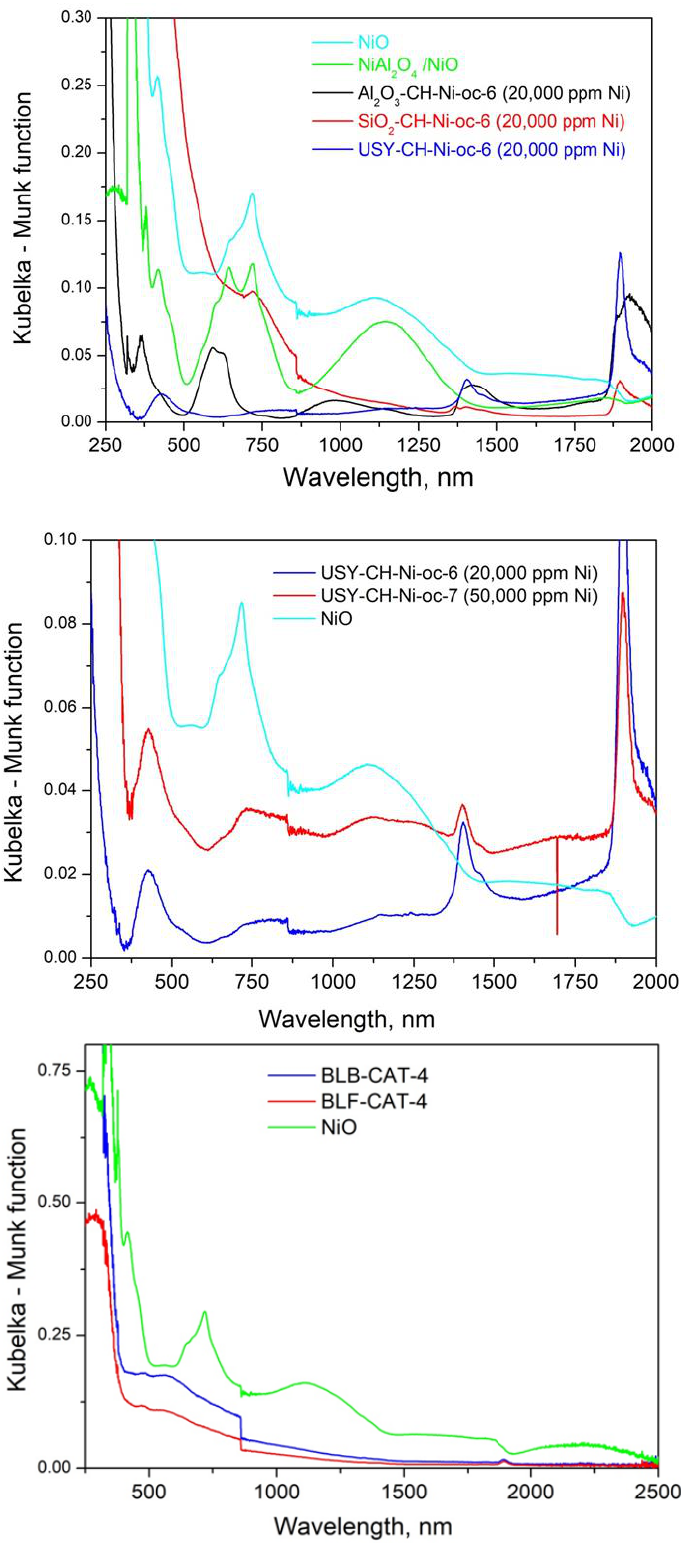
Figure 11. UV-Vis near IR diffuse reflectance spectra of representative Ni-impregnated materials: SiO 2 -CH-Ni-oc-6 (2 wt.% Ni), Al 2 O 3 -CH-Ni-oc-6 (2 wt.% Ni), USY-CH-Ni-oc-6 and 7 (2 and 5 wt.% Ni), and FCC catalysts BLF-CAT-4 and BLB-CAT-4 with 1 wt.% Ni. The spectra of bulk NiO and NiAl 2 O 4 /NiO are also included for comparison.